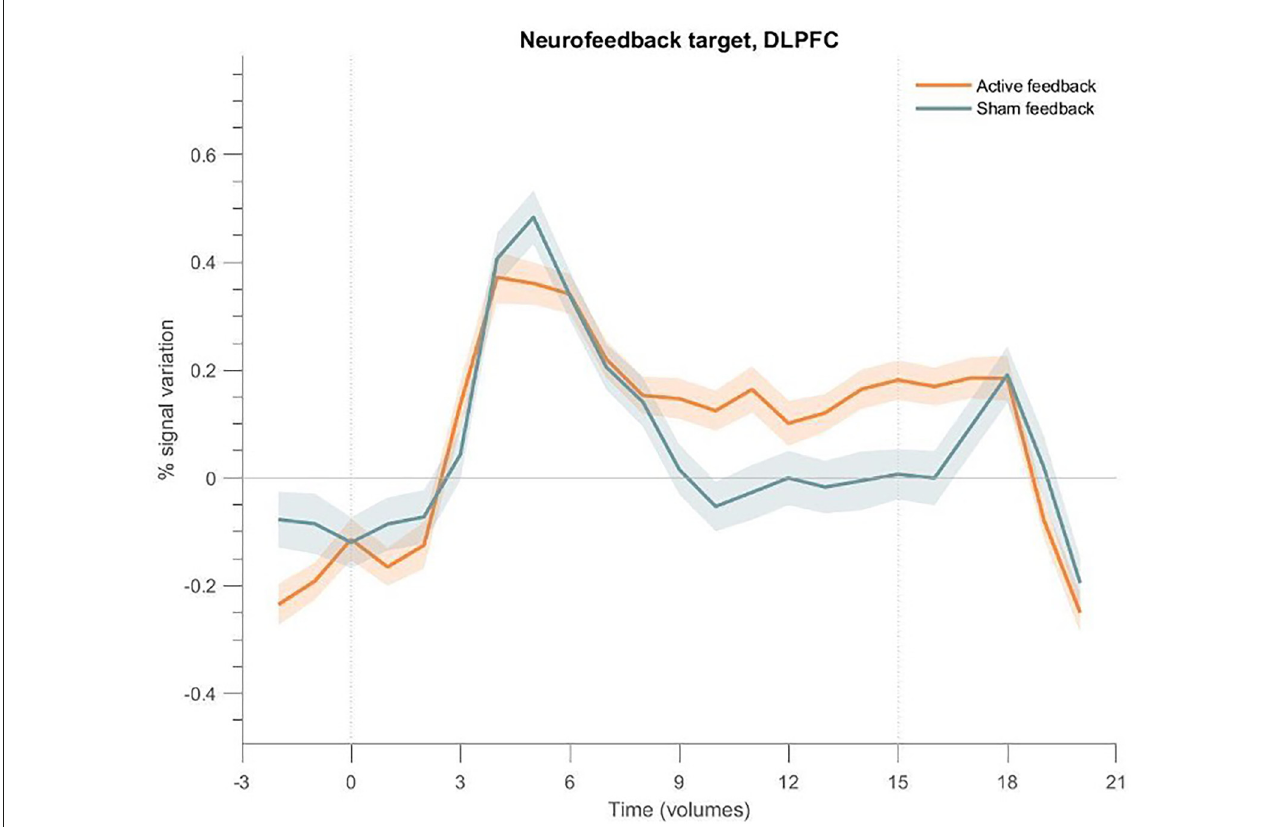
FIGURE8 Event-related fMRI time courses considering the neurofeedback target region for the active neurofeedback group (orange line) and the Sham feedback group (blue line); the shaded regions correspond to the standard error of the mean (SEM). The first dotted vertical lines indicate the up-regulation block onset and the second to the end. DLPFC exhibits greater activation for the active feedback and sham feedback groups. Both groups present an increase at the beginning of the block, but only the active neurofeedback group sustains high activity levels; the Sham feedback group returns to baseline levels after a few